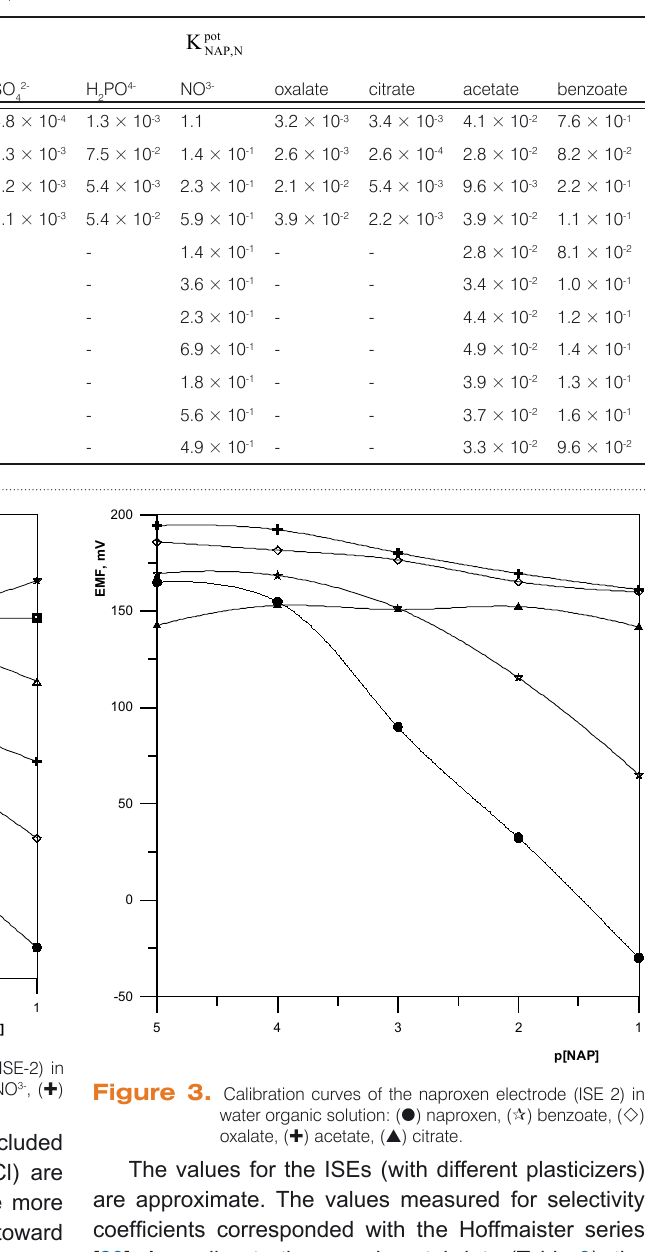
Table 3. Potentiometric selectivity coefficients, pot